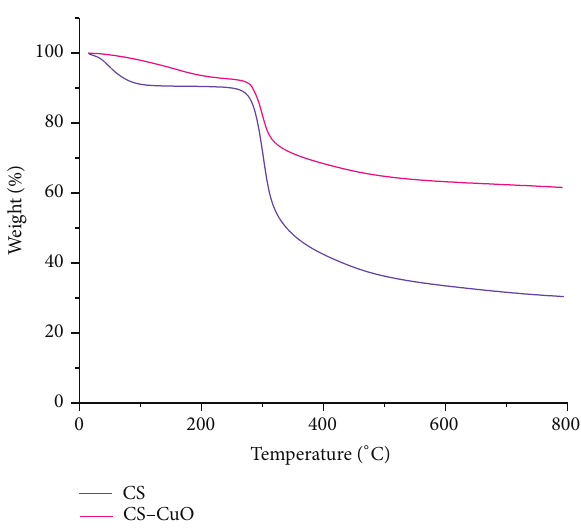
Figure 3: TGA curves of CS and CS-CuO